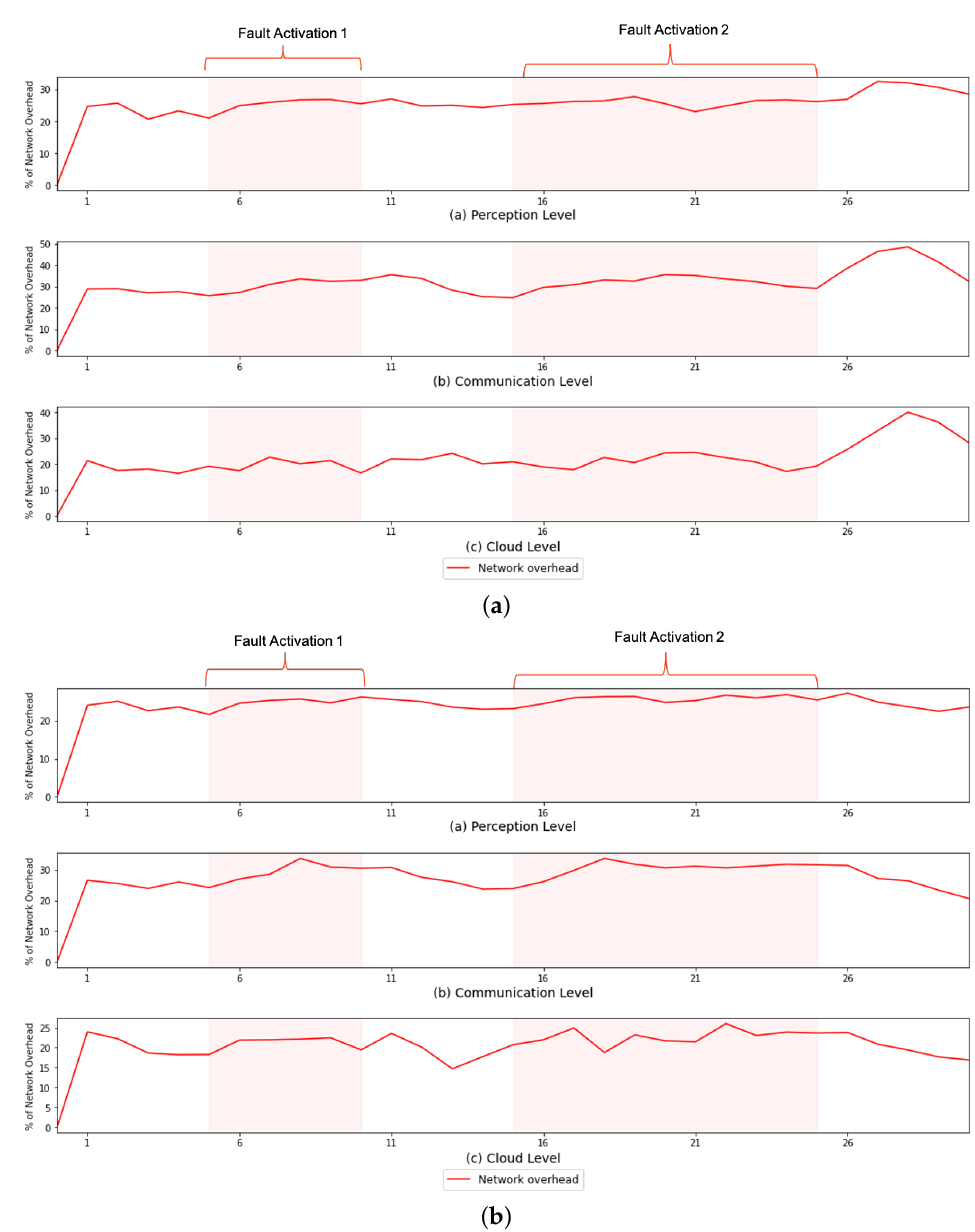
Figure 8. A comparison of the CPU overhead over time in each experimental scenario. ( a ) S#1— network overhead over time. ( b ) S#2—network overhead over